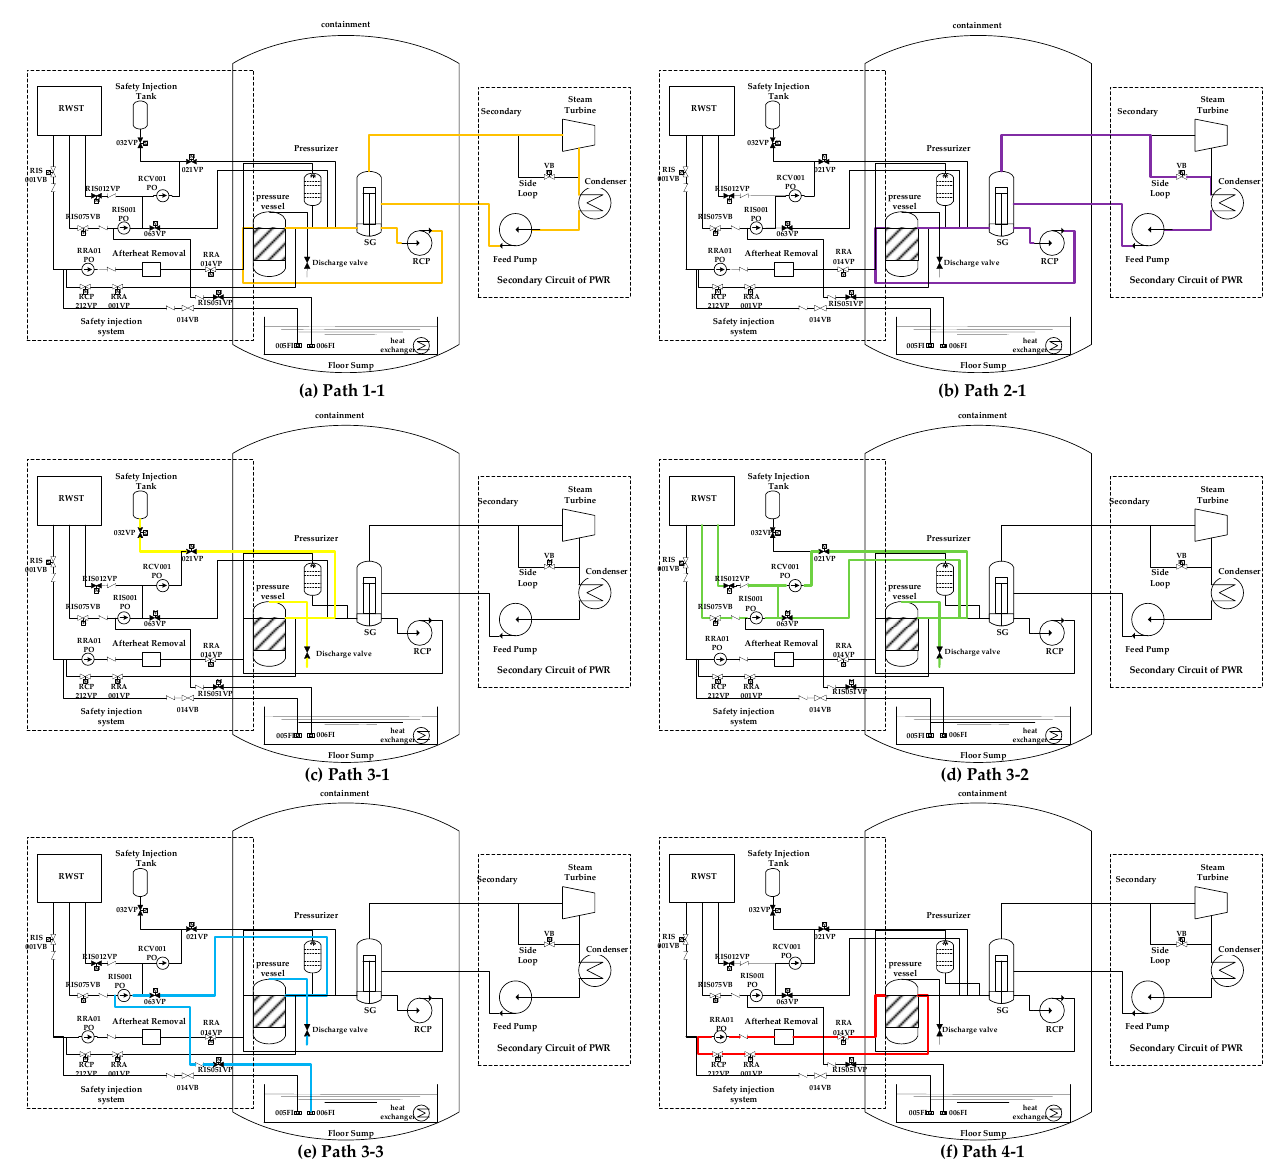
Figure 9. The required mass and energy flows corresponding to each success